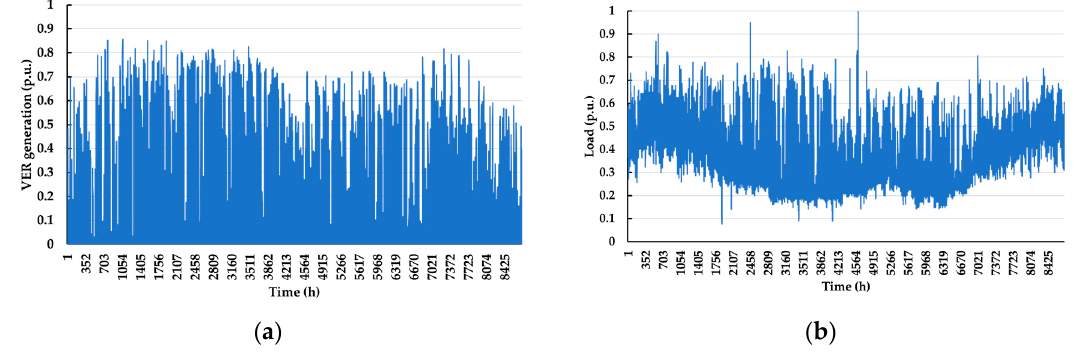
Figure 9. Annual data: ( a ) Load demand; ( b ) VER generation.